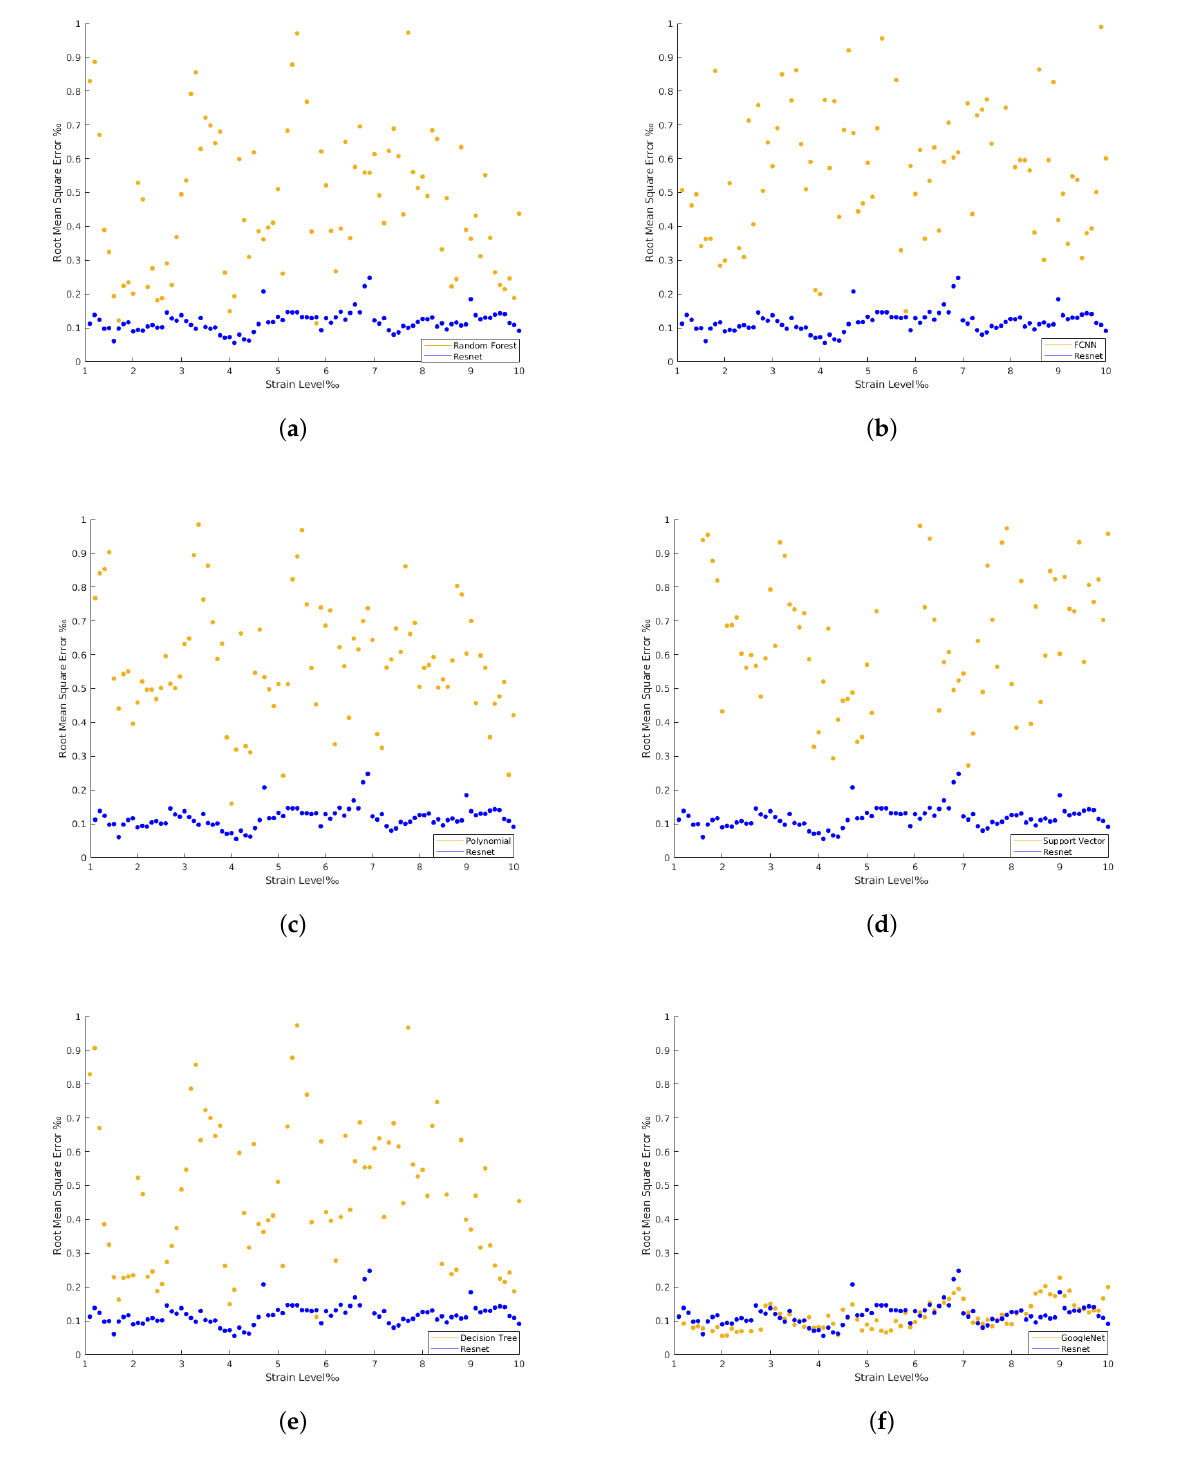
Figure 14. ResNet with regression RMSE vs. the rest. ( a ) ResNet with regression RMSE vs. Ran- dom Forest Regression RMSE. ( b ) ResNet with regression RMSE vs. FCNN with regression RMSE. ( c ) ResNet with regression RMSE vs. Polynomial Regression RMSE. ( d ) ResNet with Regression RMSE vs. Support Vector Regression RMSE. ( e ) ResNet with regression RMSE vs. Decision Tree Regression RMSE. ( f ) Resnet with regression RMSE vs. GoogLeNet with regression